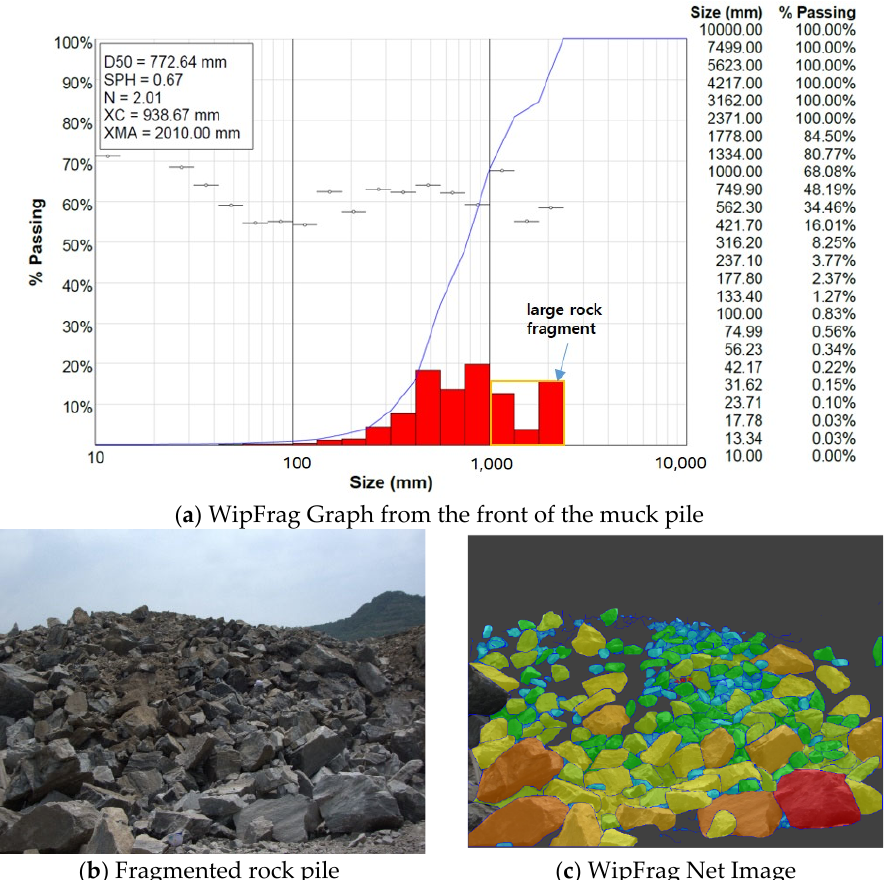
Figure 15. Rock pile image, contouring, histogram, and cumulative size curve of fragmented block (bench front image of STF stemming case after blasting).